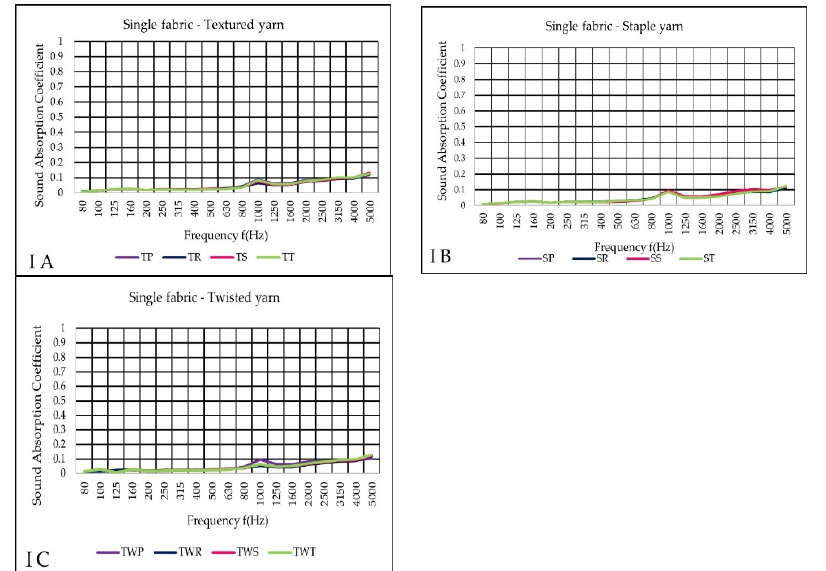
Figure 5. Sound absorption coefficient ( α ) versus frequency f (Hz) result of measurement variant (I) ( A – C ) single woven fabric.